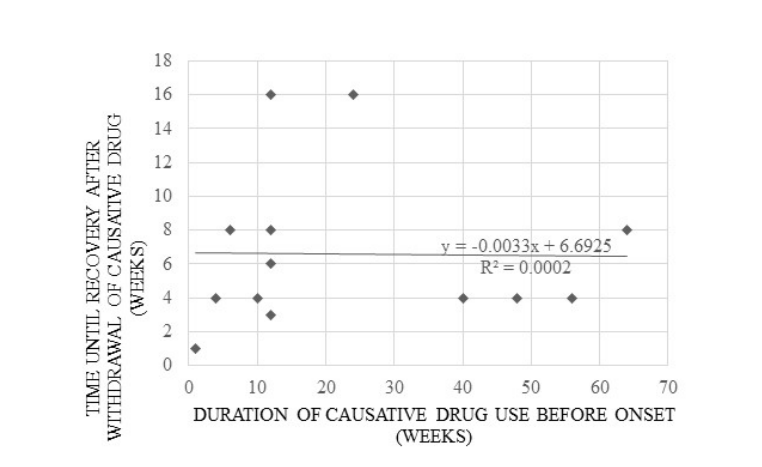
Figure 4. There was no significant correlation between duration of use of the causative drug before DIP onset and time to recovery after drug